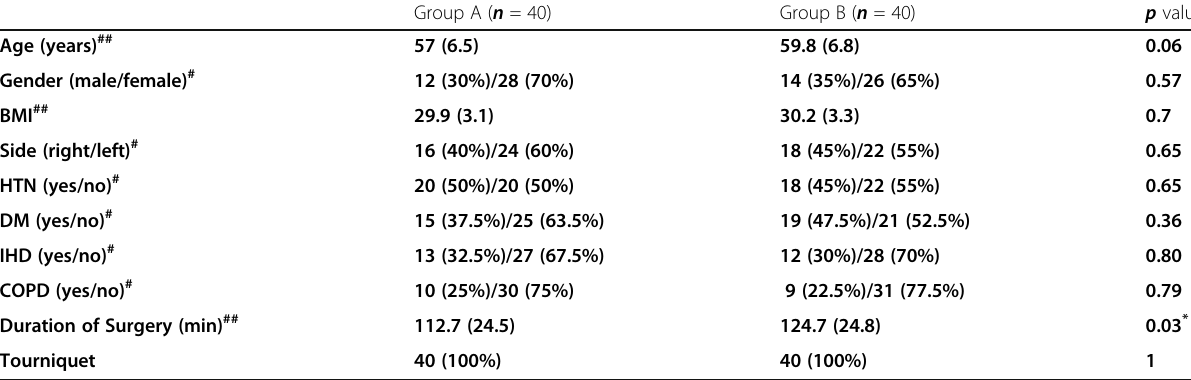
Table 1 Baseline variables and demographic data in the two groups